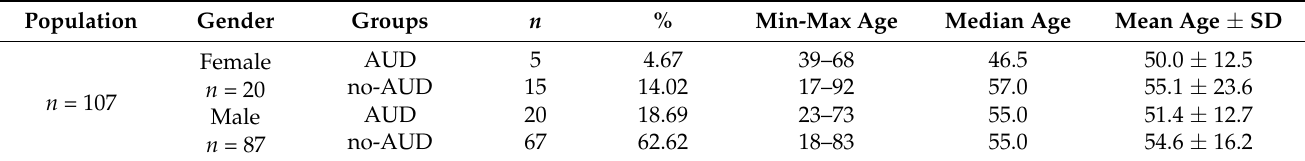
Table 1. The demographic characteristic of the groups enrolled in the